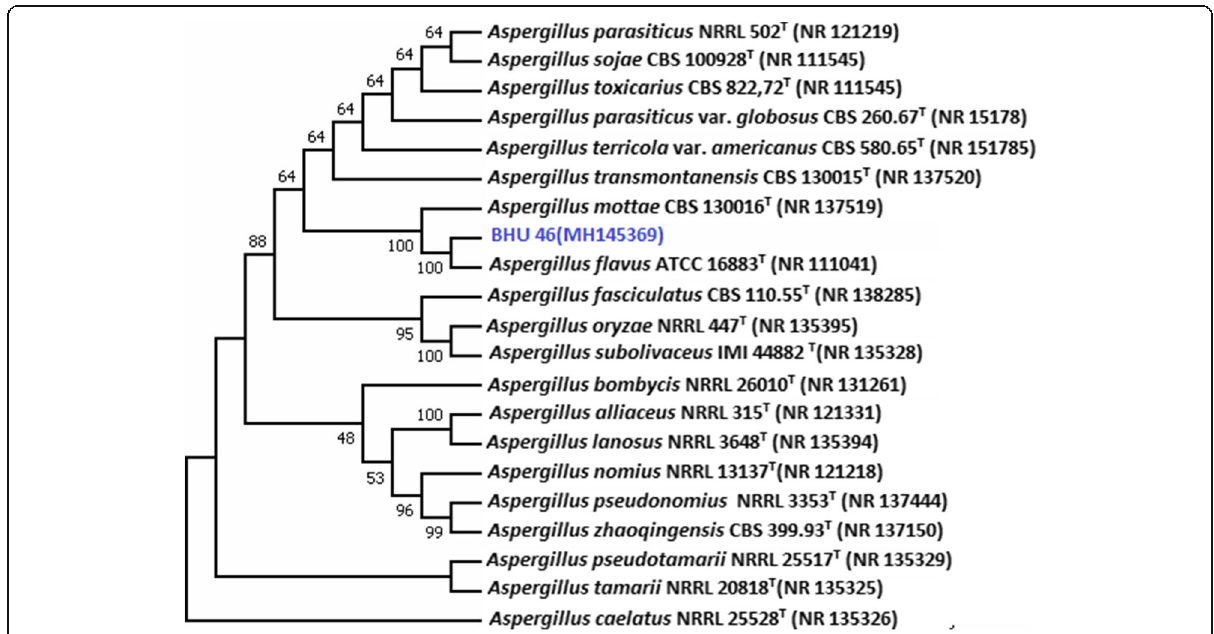
Fig. 6 Phylogenetic tree of isolate BHU-46 obtained by maximum likelihood method based on the Kimura 2-parameter model. The percentage of replicate trees in which the associated taxa clustered together in the bootstrap test (1000 replicates) are shown next to the branches. The position of Isolate BHU 46 is shown with blue color. It is most closely related with Aspergillus flavus and supported by boot strap value of